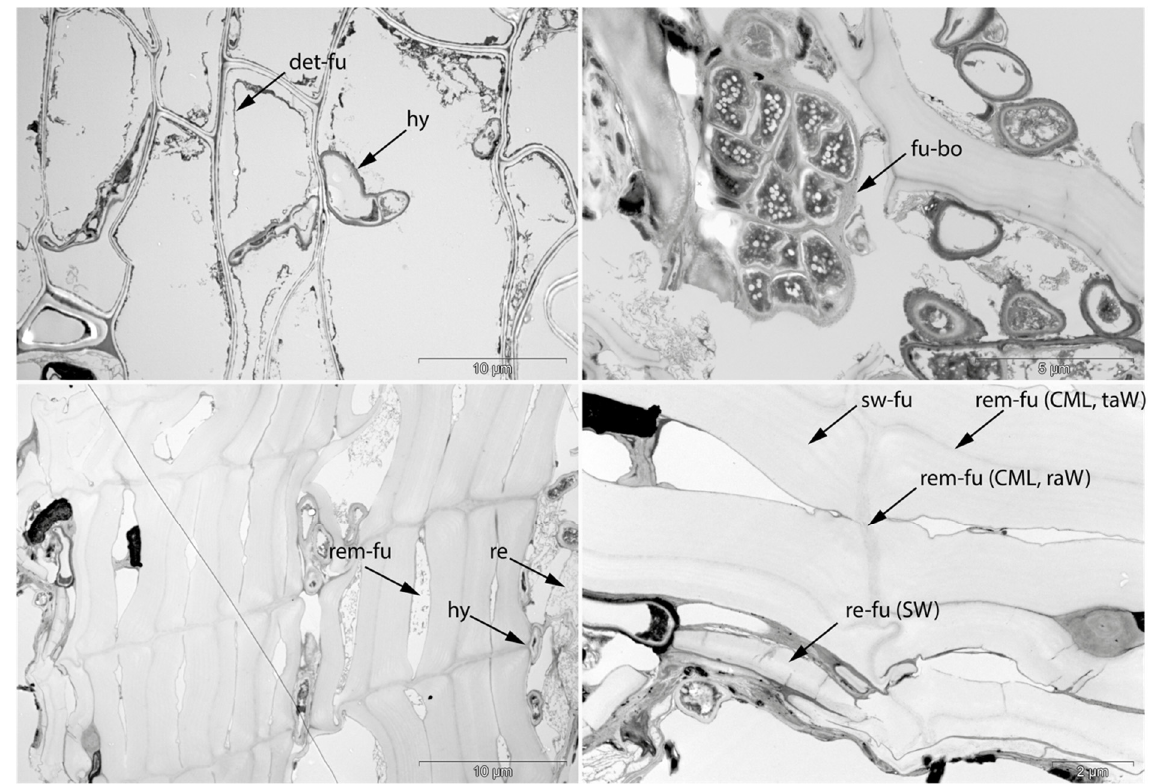
Figure 15. Sample 0. TEM images illustrating degradation feature called circular voids. At top right, empty cavities not filled with hyphae are visible (vo-fu). In the same picture, swelling and loosening of secondary cell wall can be seen (sw- fu). At bottom right, cells with corners penetrated by hyphae (hy) are visible. These have almost completely metabolised the suberised wall, leaving only a little granular dark residue (re).